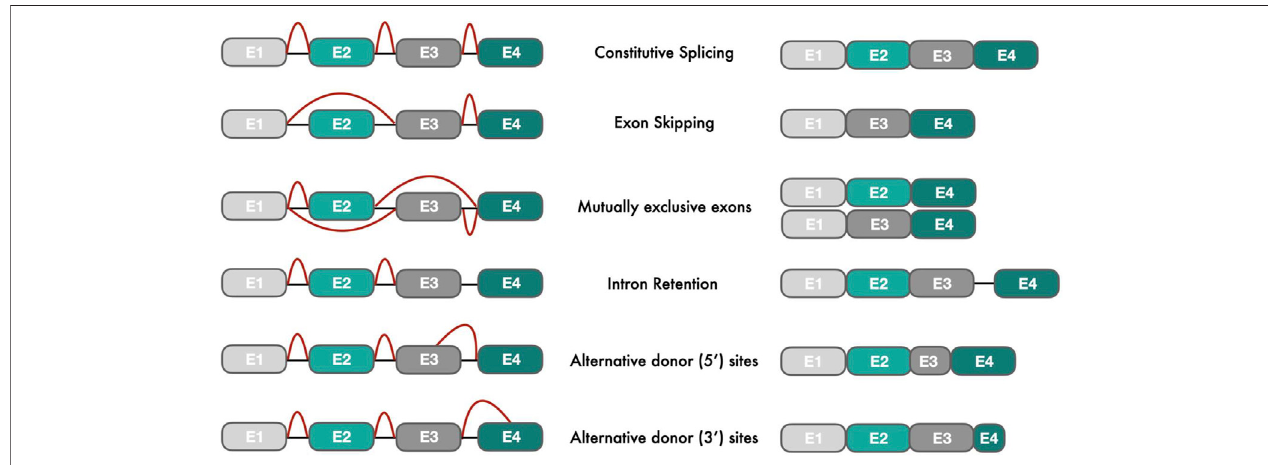
FIGURE 1 | Types of alternative splicing events: The left fi gure shows different pre-mRNA transcripts with exons (E) in different colors and introns as black connecting lines. Red lines indicate splicing events that join exons intro processed mRNA transcripts (right part of the fi gure).